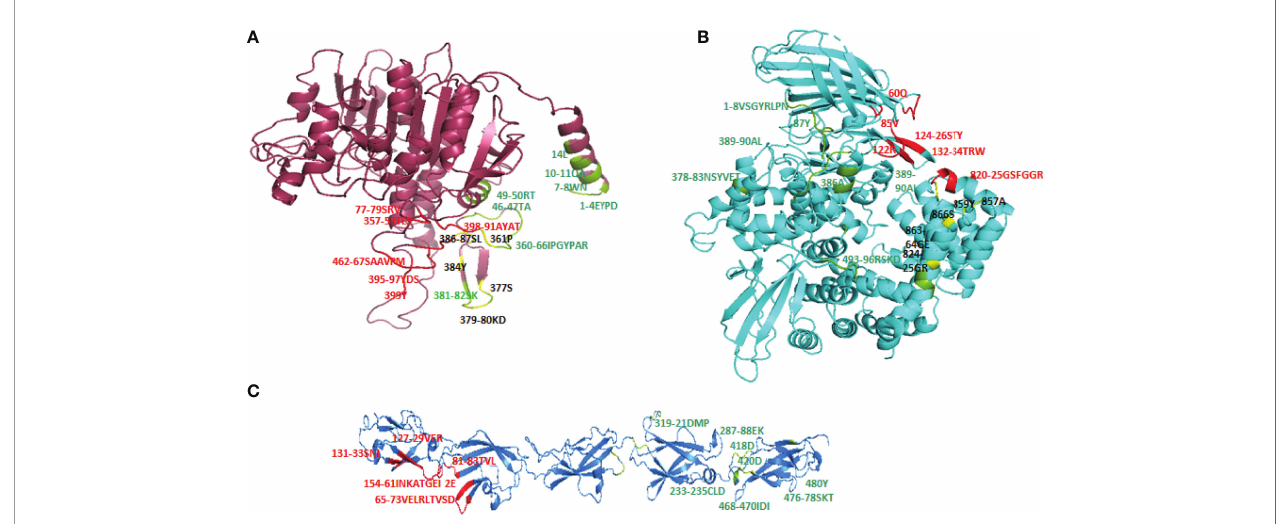
FIGURE 6 | Overlapping binding sites in receptors interface. When both CTL and Cry11Aa proteins docked together in ALP, APN and Cadherin receptors overlapping binding sites (colored in yellow) were found in (A) ALP and (B) APN but none of residue in Cadherin receptor (C) found to be overlapped. Red colored residues are CTL binding sites while Cry11Aa binding sites are colored in green smudge.